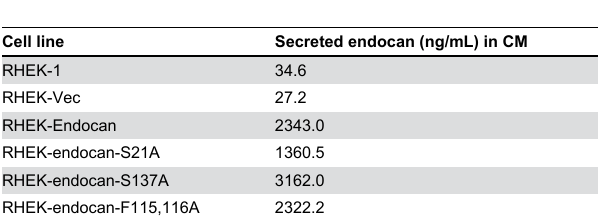
Table 3. Concentration of endocan in the conditioned medium of RHEK-1-derived cell